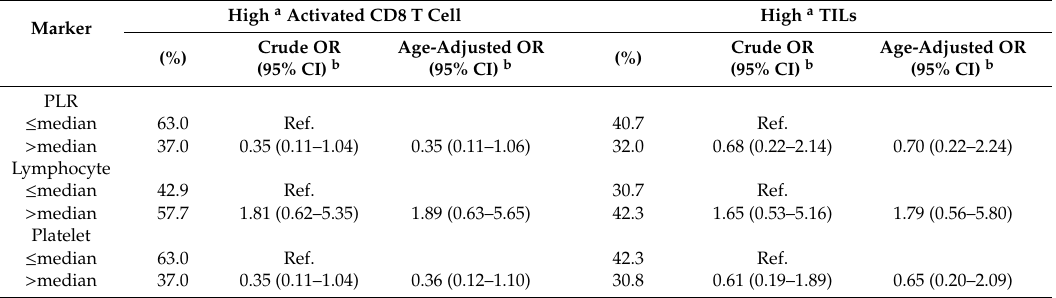
Association between markers of systemic inflammation and tumor infiltrating lymphocytes